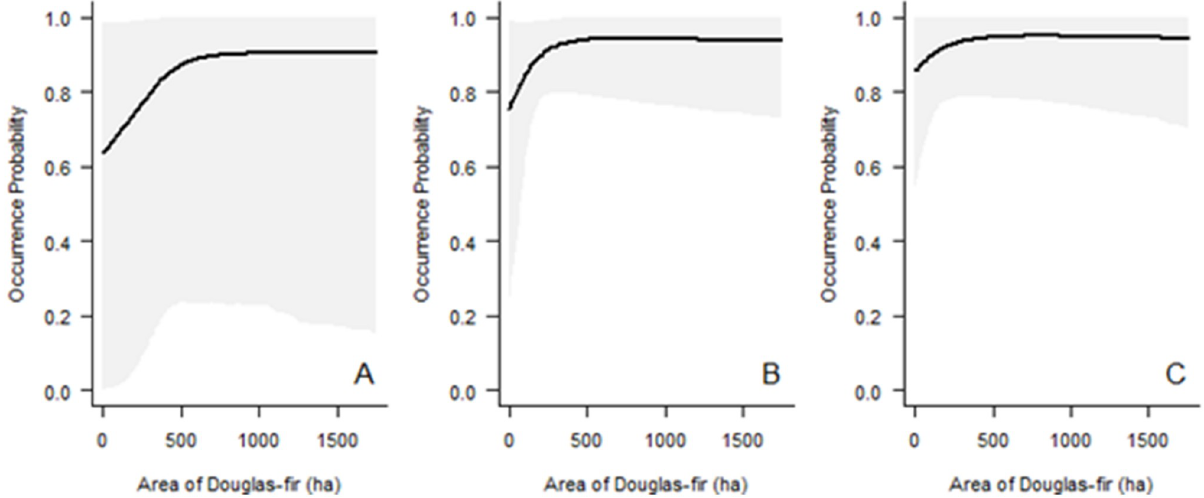
Fig 6. Predicted probability of Clark’s nutcracker occurrence during the post-harvest as a function of the area of Douglas-fir and whitebark pine on the landscape. The graphs depict predictions based on data from infinite radius surveys. Values represent area of Douglas-fir habitat within 3.2 km. Area of whitebark pine is held at the (A) minimum, (B) mean, and (C) maximum, and all other variables are held at the mean. Gray shaded areas denote 95% Bayesian Credible Intervals.